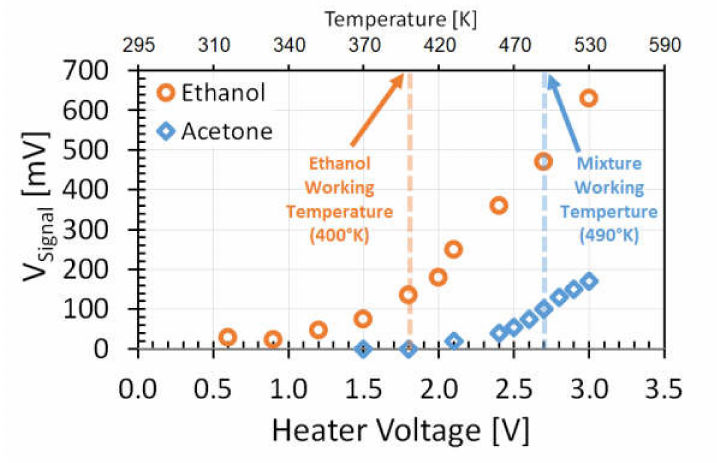
Figure 10. Ethanol and acetone output signal as function of heater voltage applied to heating resistor, and temperature at constant acetone concentration of 100